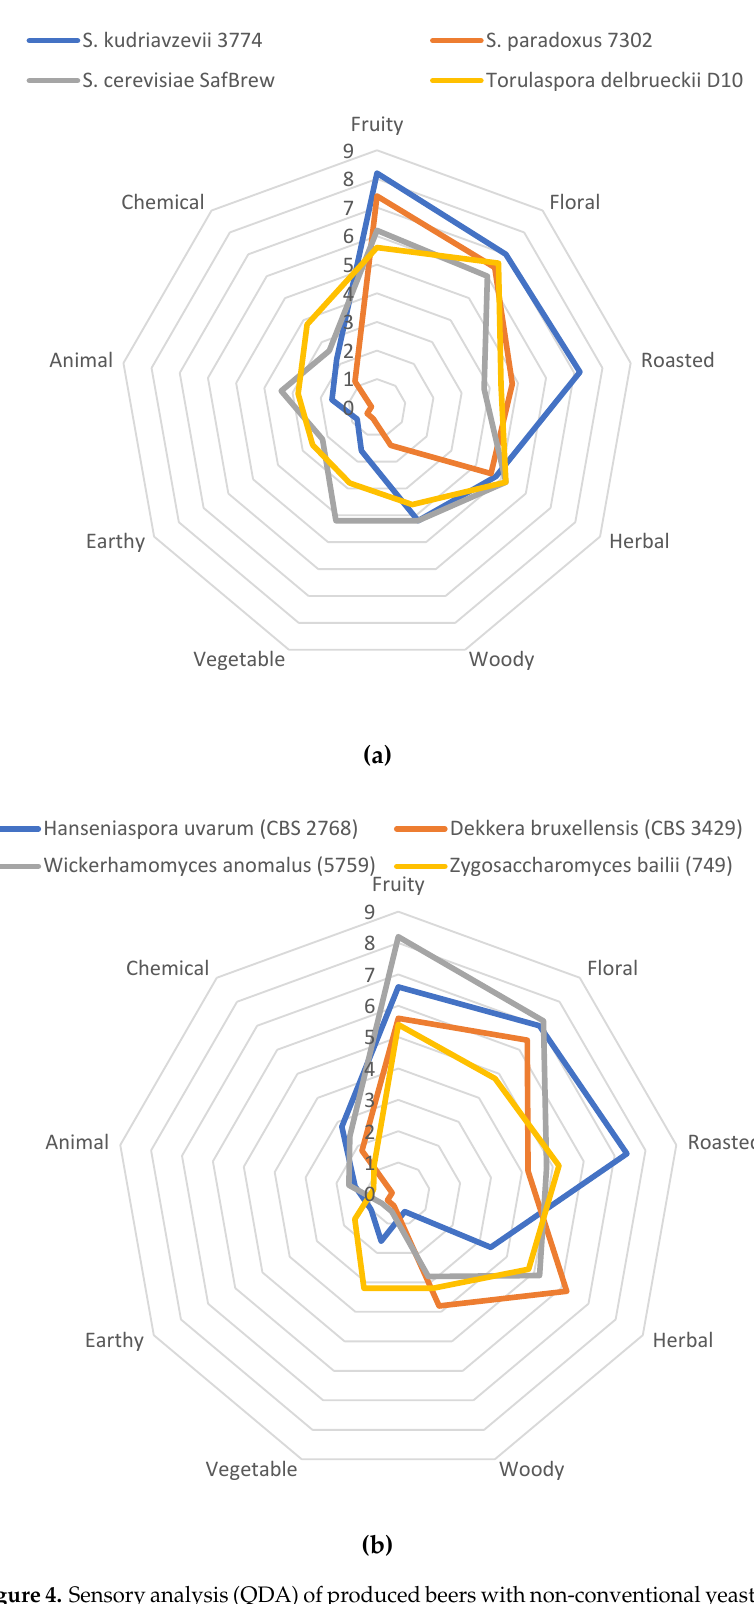
Figure 4. Sensory analysis (QDA) of produced beers with non-conventional yeasts. ( a ) — Saccharomyces yeast and Torulaspora delbrueckii ; ( b ) — other non -Saccharomyces yeast.